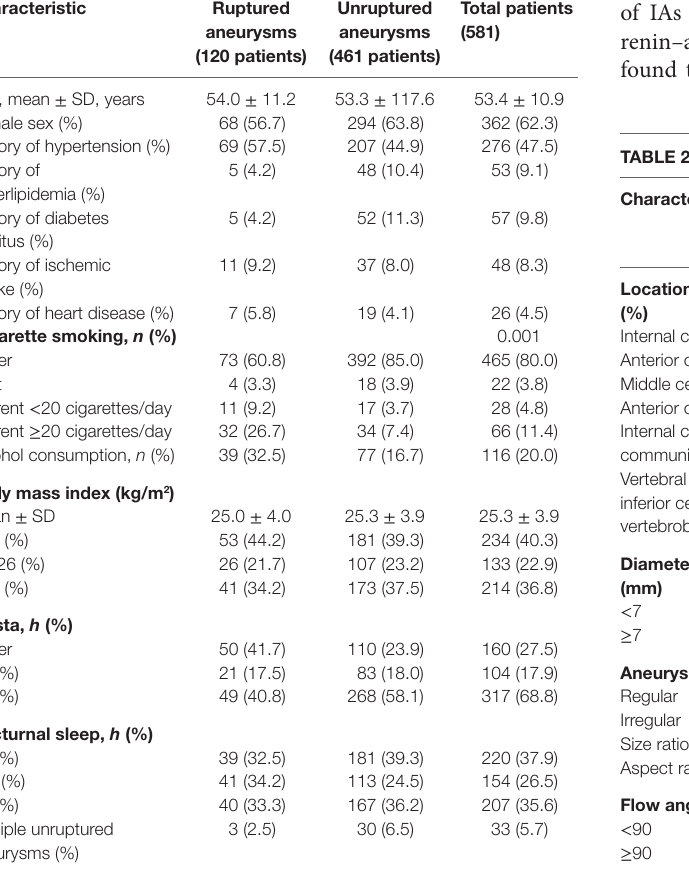
TaBle 1 | Patient